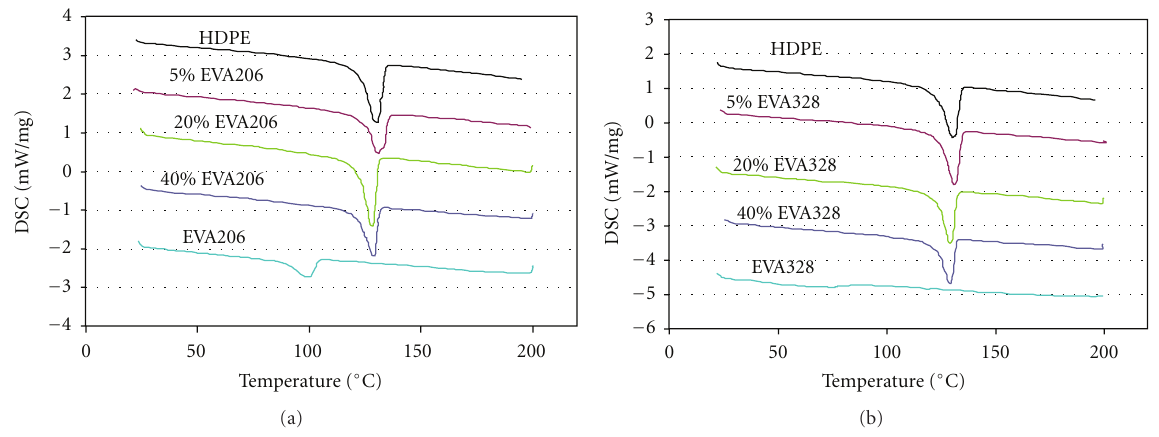
Figure 3: (a) DSC thermal curves of HDPE, EVA206, and their blends. (b) DSC thermal curves of HDPE, EVA328, and their blends.